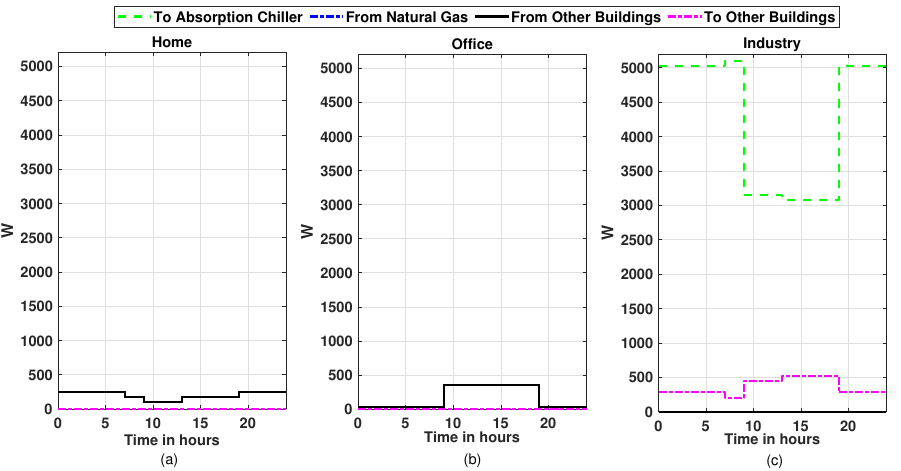
Figure 12. Heating cooperation among the buildings for 24 h in the month of June, ( a ) for the home building, ( b ) for office building, and ( c ) for industry building.